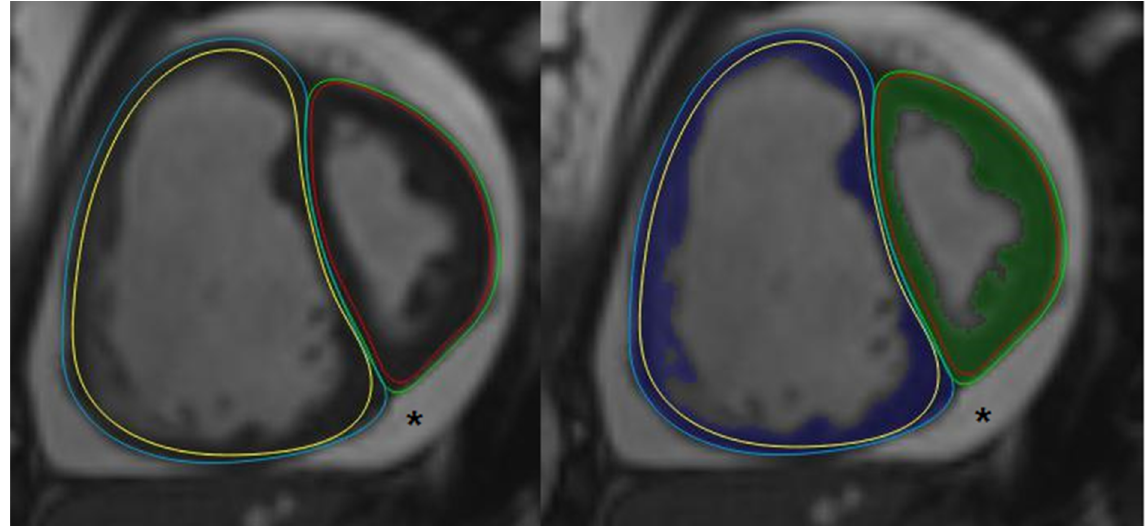
Figure 1. Left image: Manually drawn epicardial (blue line) and endocardial (yellow line) borders of the right ventricle, and epicardial (green line) and endocardial (red line) borders of the left ventricle. Right image: MassK mode ® has been activated, incorporating trabeculae and papillary muscle as mass (blue and green are in the right and left ventricle, respectively). * This patient has a prominent layer of pericardial fl uid.